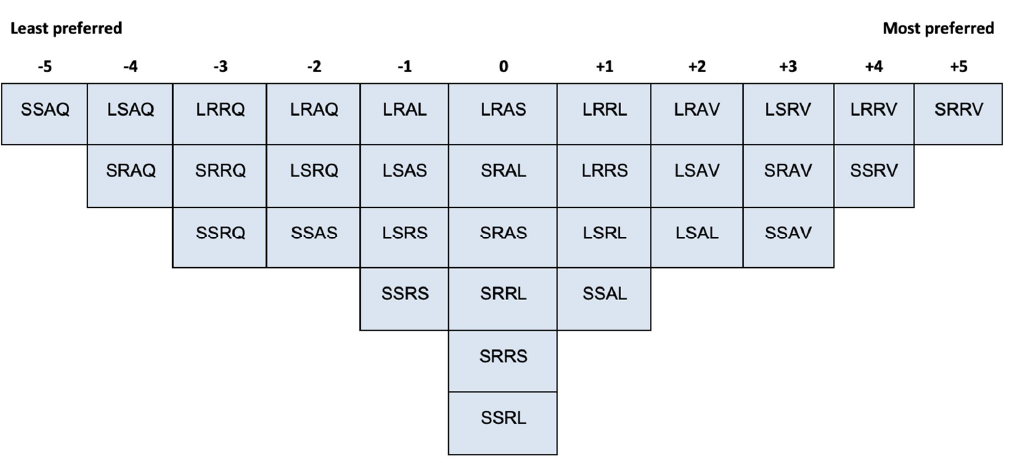
Figure 8. The shared Q-sorting result of participants loaded on Q-factor 2.